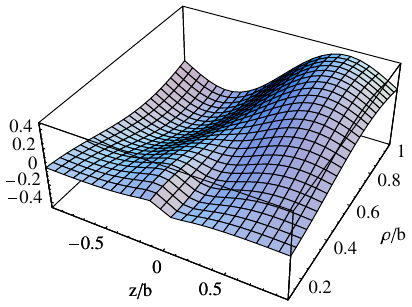
FIG. 5. The longitudinal force F p ¼ 0 . 1 . FIG. 6. The same as in Fig. 5 with p ¼ 5 . 0